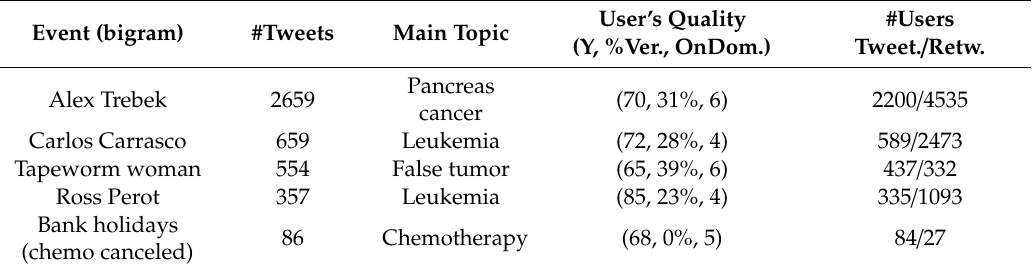
Table 3. Top frequent events